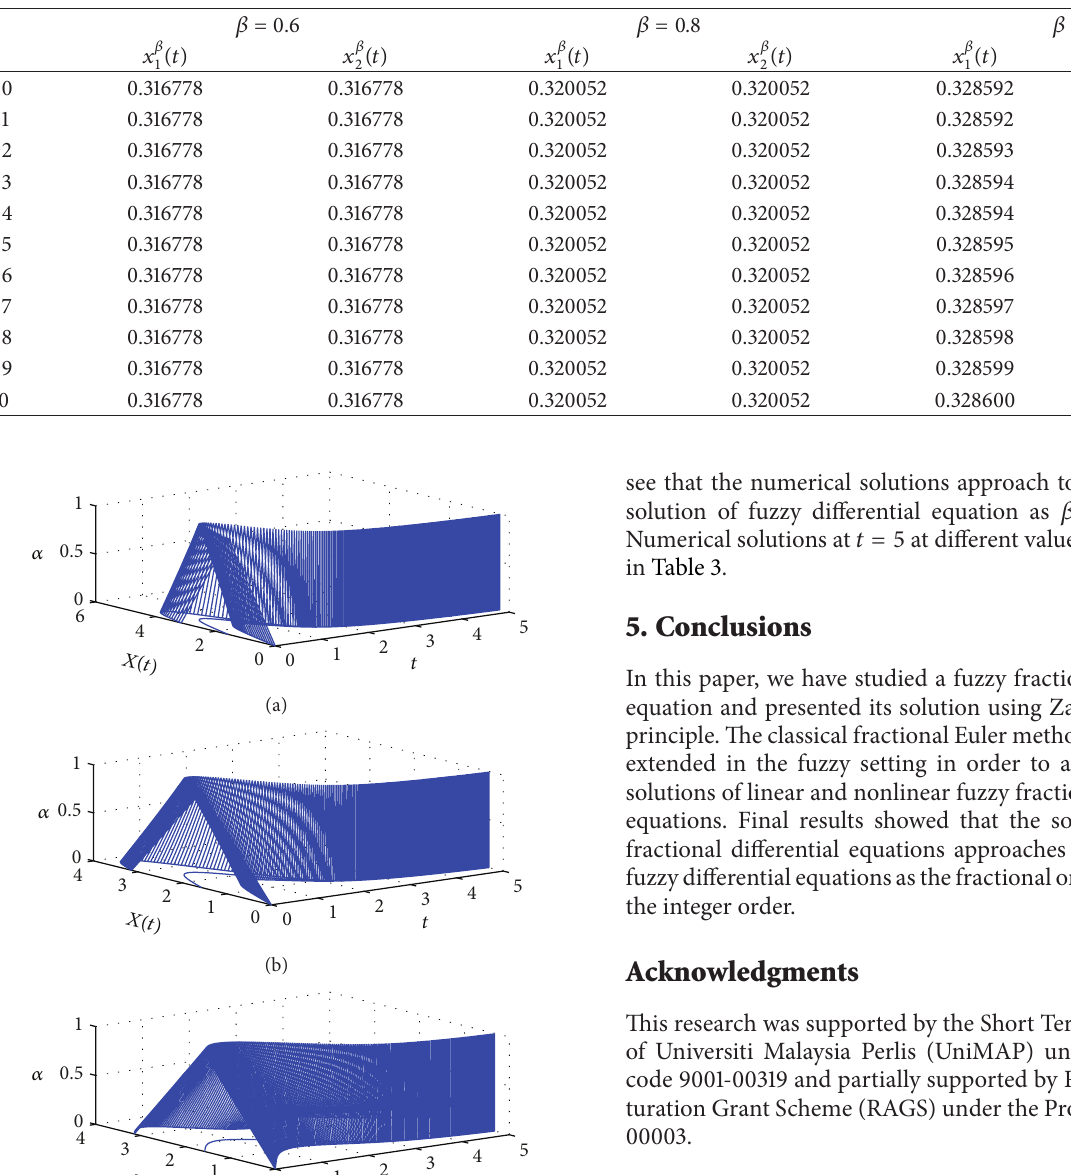
Table 3: Numerical solutions of Example 3 with different values of 𝛽 .